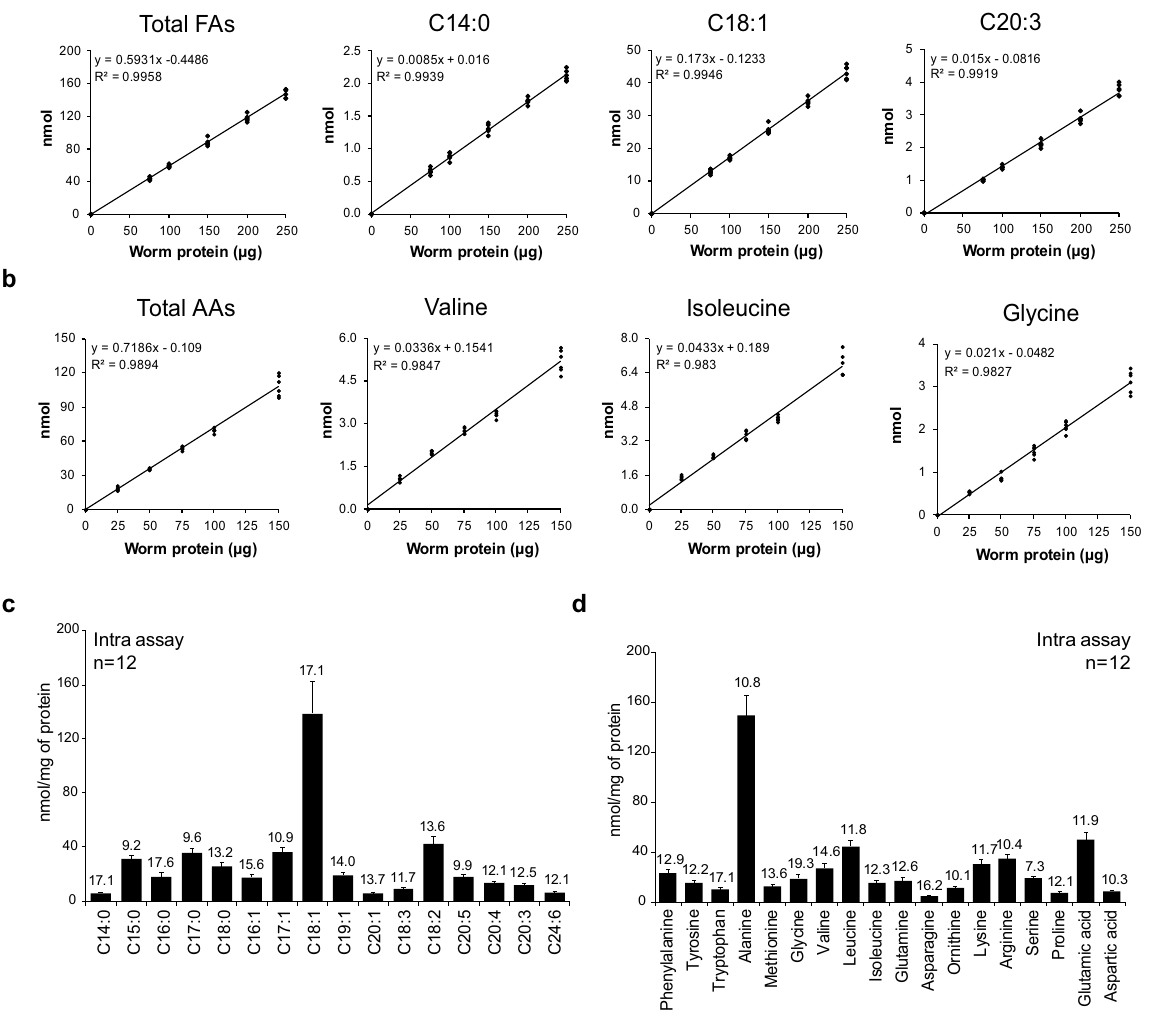
Figure 1. Linearity and precision of fatty acid (FA) and amino acid (AA) analysis in C. elegans . ( a ) FAs were extracted from increasing amount of worm protein lysate (0–250 µ g) and measured using MS. A total of 35 FAs were detectable. A subset of FAs is shown here. ( b ) AAs were extracted from 0–150 µ g of worm protein lysate and measured using UPLC-MS/MS. Eighteen AAs were detected and considered linear. A subset of AAs is shown here. ( c , d ) Twelve identical biological samples were independently extracted and measured within the same analytical run to determine intra-assay (within day variation) variation for FAs ( c ) and AAs ( d ). Bar graphs are expressed as mean ± SD. Values above the bars indicate the coefficient of variation. See also Supplementary Fig. S1 and Supplementary Table